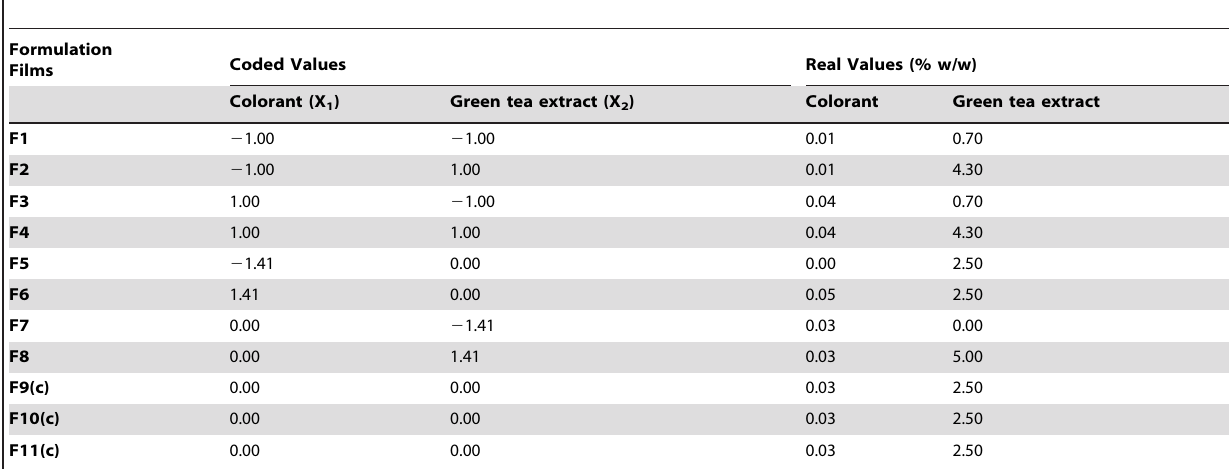
Table 1. Coded and real values of green tea extracts and colorants added to cassava starch bio based films according to a (2 2 ) second order experimental design with 3 central points.